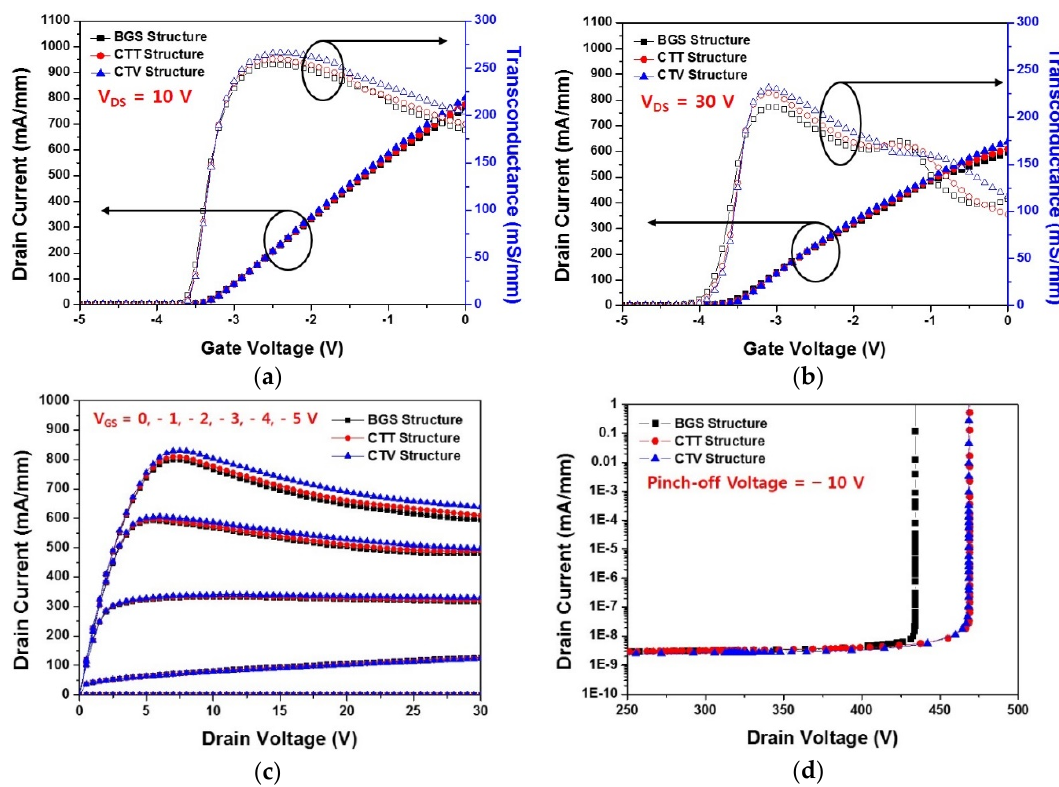
Figure 7. Comparison of the DC characteristics considering the SHE for the BGS, CTT, and CTV structures: I–V transfer characteristics at ( a ) V DS = 10 V and ( b ) V DS = 30 V; ( c ) saturation current when gate voltages were −5, −4, −3, −2, −1, and 0 V; and ( d ) breakdown characteristics at a pinch-off of V GS = −10 V.